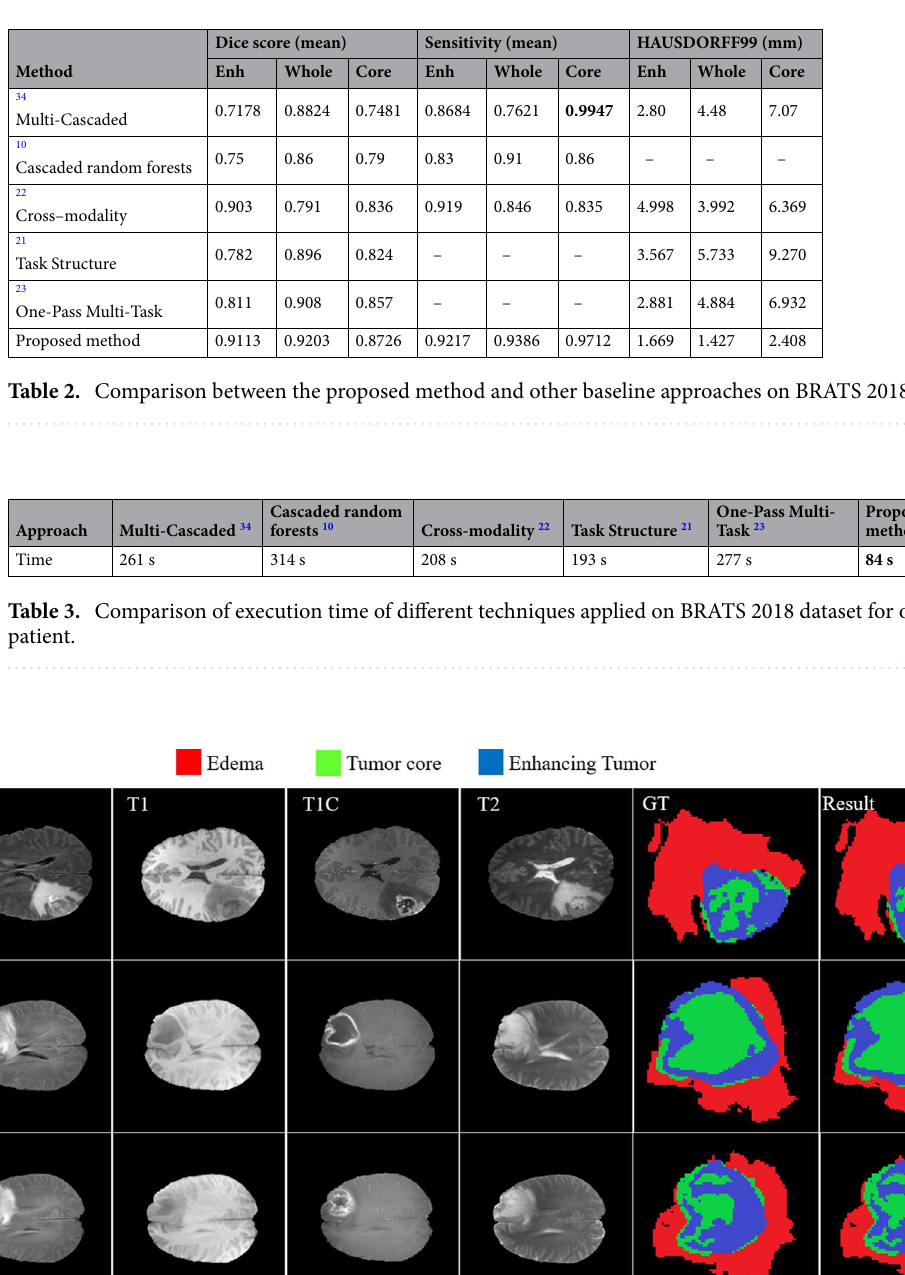
Figure 13 provides a visual demonstration of the good results achieved by our approach on the BRATS 2018 dataset. As shown, all regions have a mutual border with all of the other regions. Due to the difference between the value of tumor core and enhancing areas inside the T1C images (third column), the border between them can be easily distinguished with a high rate of accuracy without using other modalities. But it is not true when we are dealing with the border of a tumor core, edema areas, or enhanced edema areas. Due to these mentioned characteristics of each modality, we observe that there is no need for a very deep CNN model if we decrease the searching area.